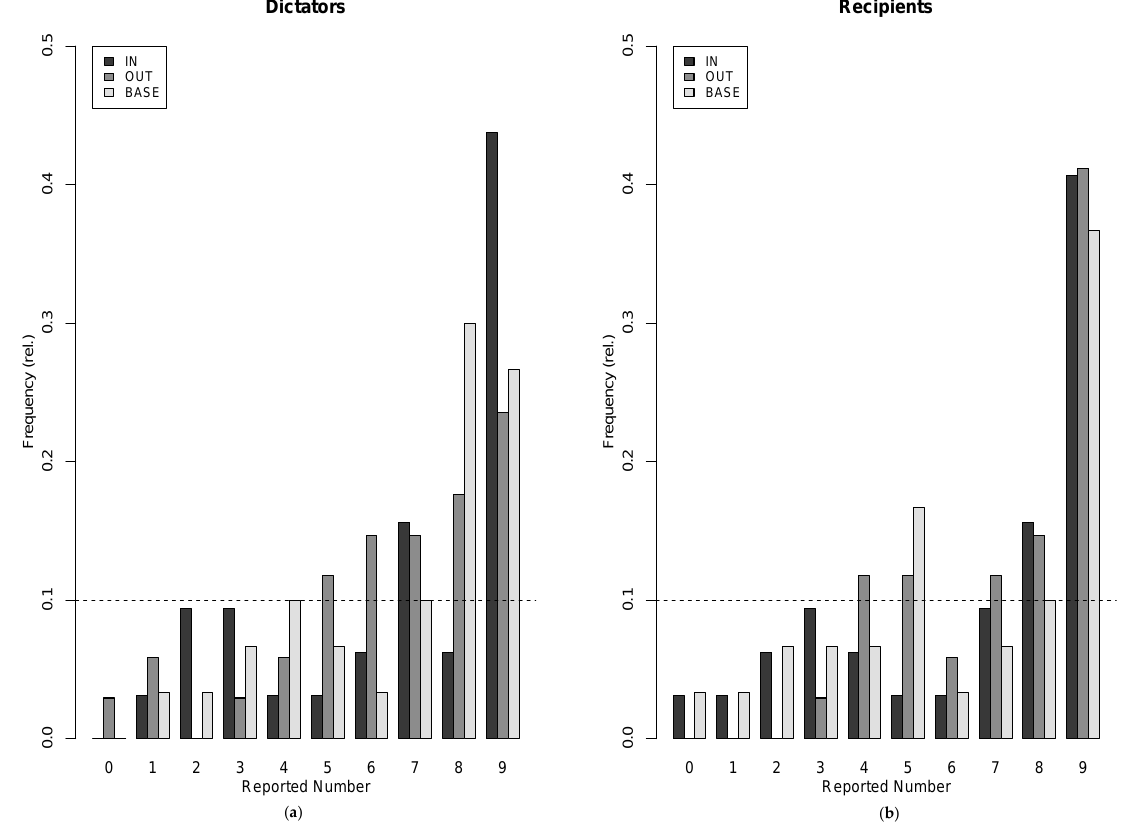
Figure 2. Self-reported numbers. Self-reported last digit number of the last phone call made by dictators ( a ) and recipients ( b ), in each of the three experimental conditions separately. The dashed horizontal line provides a reference for the ideal uniform distribution of values. To improve visualization, a small random noise is added to the